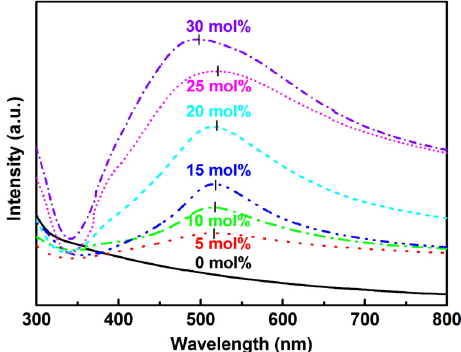
Fig. 5 Optical absorption spectra of the Ag x /BTO thin films.